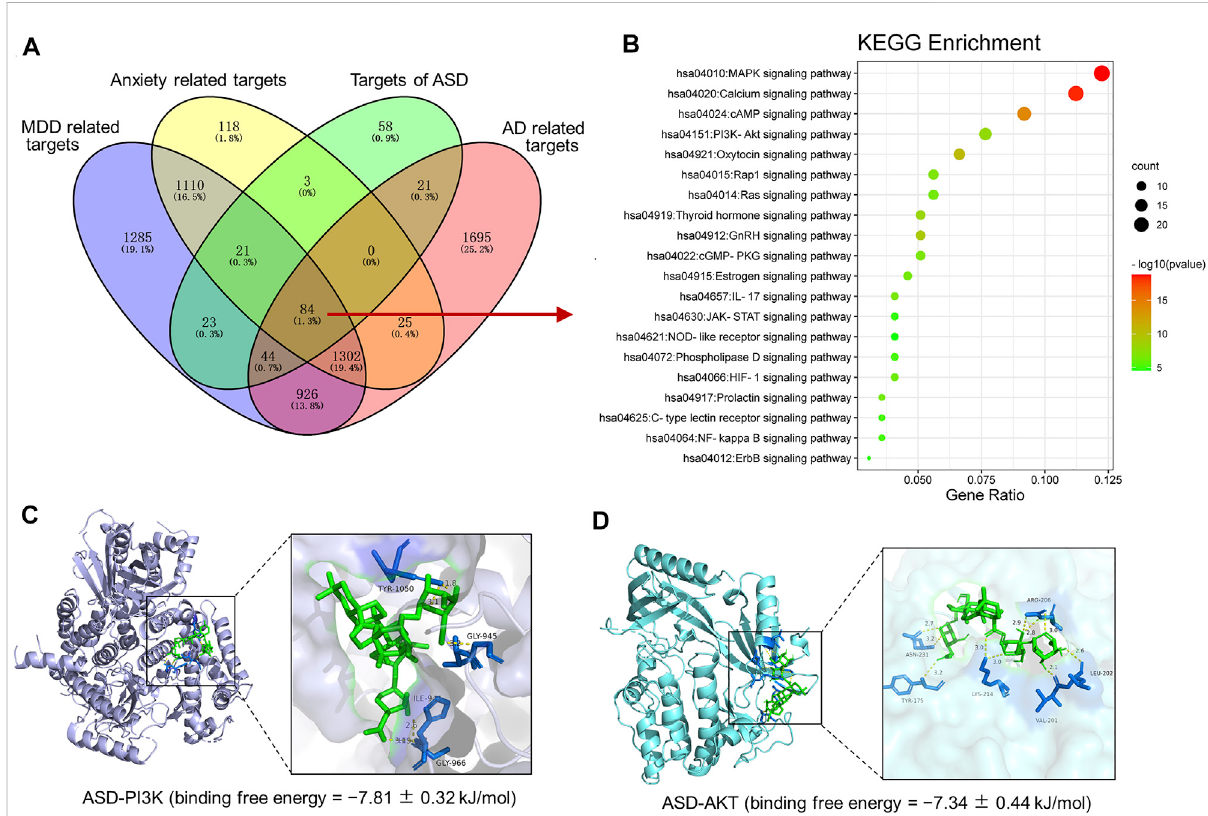
FIGURE 11 Pharmacological mechanisms of ASD against disorders involving impaired neurogenesis. (A) , Venn diagram summarizing the intersection targetsoftheakebiasaponinD(ASD),majordepressivedisorder(MDD),anxietyandAlzheimer ’ sdisease(AD). (B) ,KEGGanalysisofkeytargetsofASD in treatment of MDD, anxiety and AD. Bubble plot of top 20 KEGG pathways. (C,D) , Molecular docking diagram of ASD (green) to target PI3K (C) and Akt (D). The yellow lines represent the hydrogen bond interaction force, which is the main force promoting molecule binding with the active site. The blue positions indicate the amino acid residues of the receptors